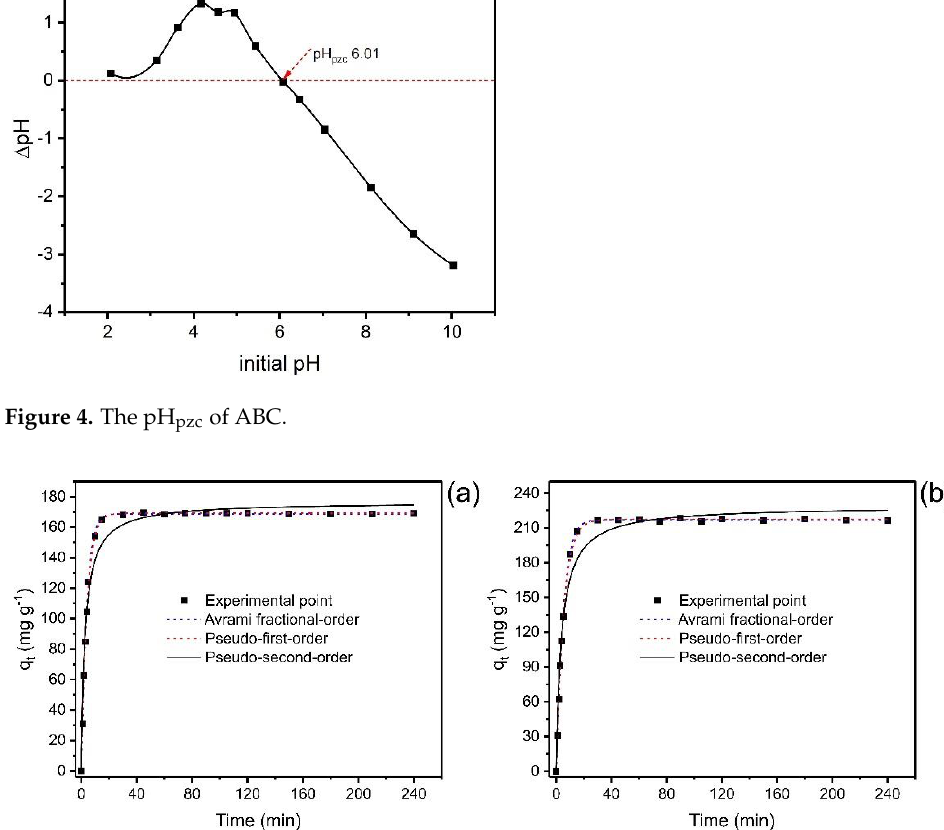
Figure 5. Kinetic curves for the adsorption of catechol. ( a ) Co 350 mg L −1 ; ( b ) 700 mg L −1 . Adsorbent mass 30 mg; temperature 25 °C, pH 7.